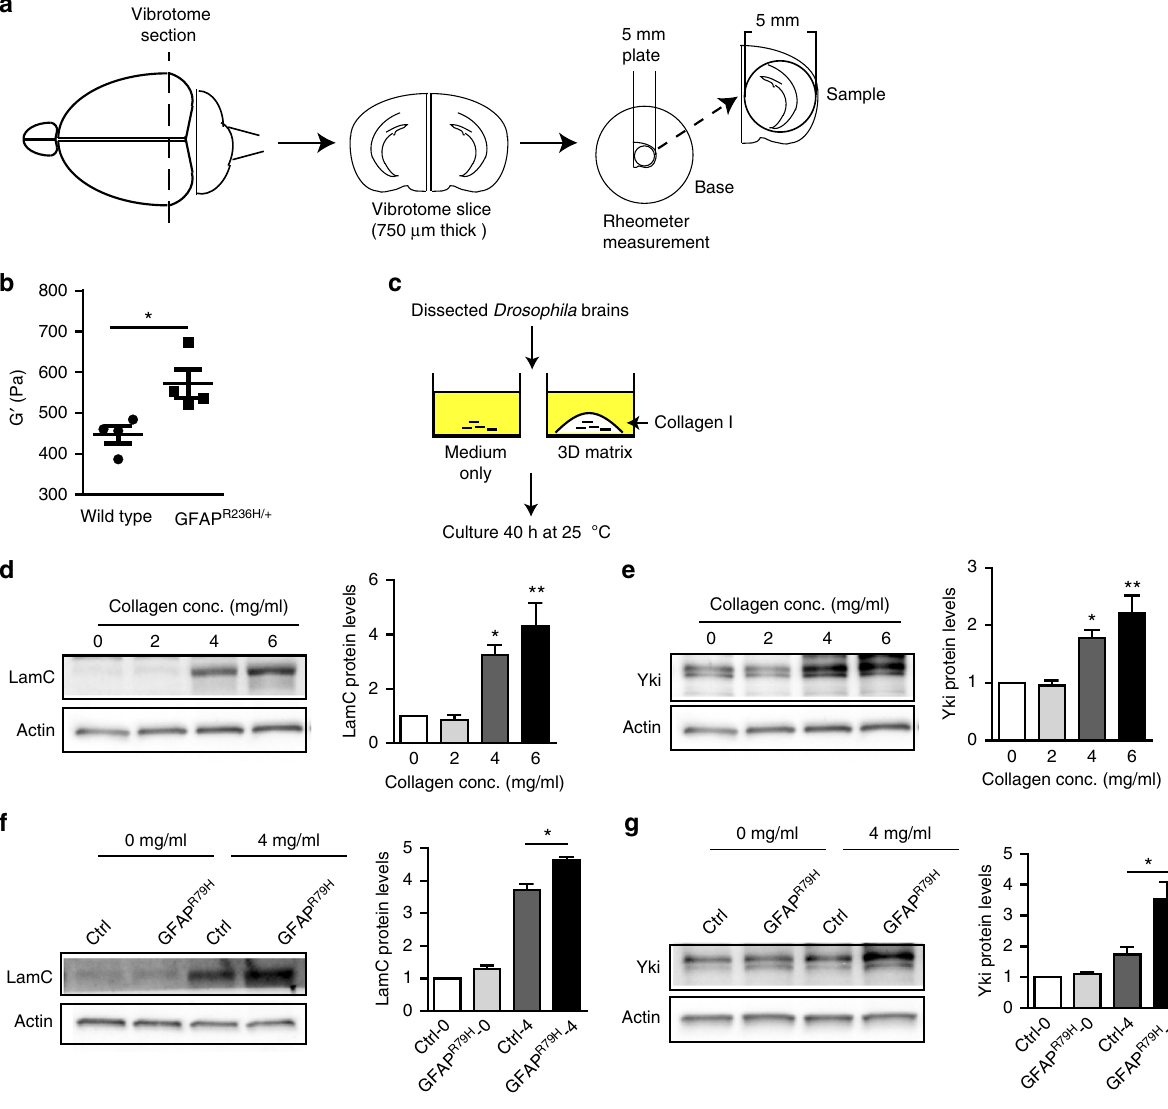
Fig. 5 Increased brain stiffness in experimental models of Alexander disease. a Schematic illustration shows elasticity measurement of 750 μ m-thick mouse brain slices with a rotational rheometer. b There is a signi fi cant increase of brain tissue stiffness in Alexander disease model mice ( GFAP R236H / + ) compared to age-matched wild-type littermate controls. Mice are 4 months old. N = 4 per genotype. p = 0.0286, Mann – Whitney test. c Schematic illustration shows ex vivo 3D-collagen matrix culture of Drosophila brain. Dissected Drosophila brains were cultured in medium alone or in 3D-collagen matrix for 40 h at 25 °C before analysis. d LamC expression dose-dependently increases with collagen matrix concentrations (stiffness). Genotype: repo - GAL4 / + (Ctrl). e Yki expression dose-dependently increases with collagen matrix concentrations (stiffness). Genotype: repo - GAL4 / + (Ctrl). f LamC expression increases signi fi cantly more in Alexander disease model fl y brains than that in control fl y brains when cultured at 4 mg/ml of collagen matrix. Genotype: Ctrl: repo - GAL4 / + ; GFAP R79H : repo - GAL4 , UAS - GFAP R79H / + . * p < 0.01. g Yki expression increases signi fi cantly more in Alexander disease model fl y brains than that in control fl y brains when cultured at 4 mg/ml of collagen matrix. Genotype: Ctrl: repo - GAL4 / + ; GFAP R79H : repo - GAL4 , UAS - GFAP R79H / + . * p < 0.01. Flies are 1 – 3 days old in all